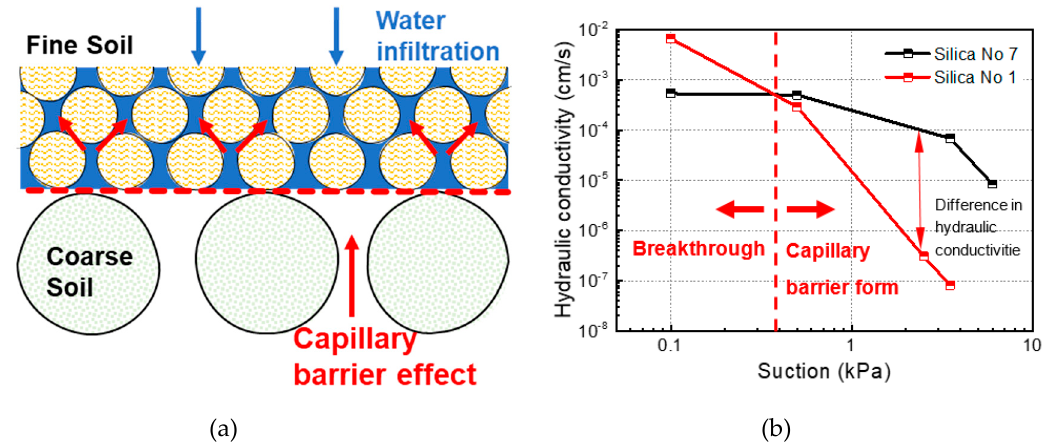
Figure 16. ( a ) Capillary barrier at the interface between different layers with different conductivities. ( b ) The relationship between the hydraulic conductivity and suction of silica No 1 and No 7.